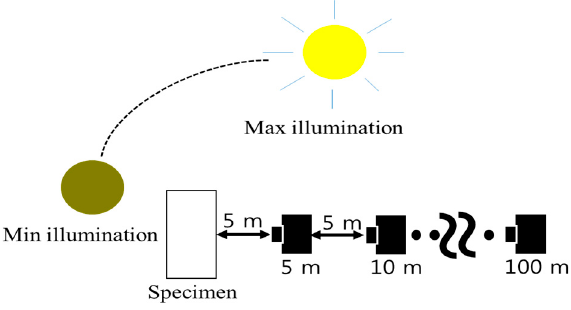
Figure 6. Schematic diagram of crack image acquisition experiment.